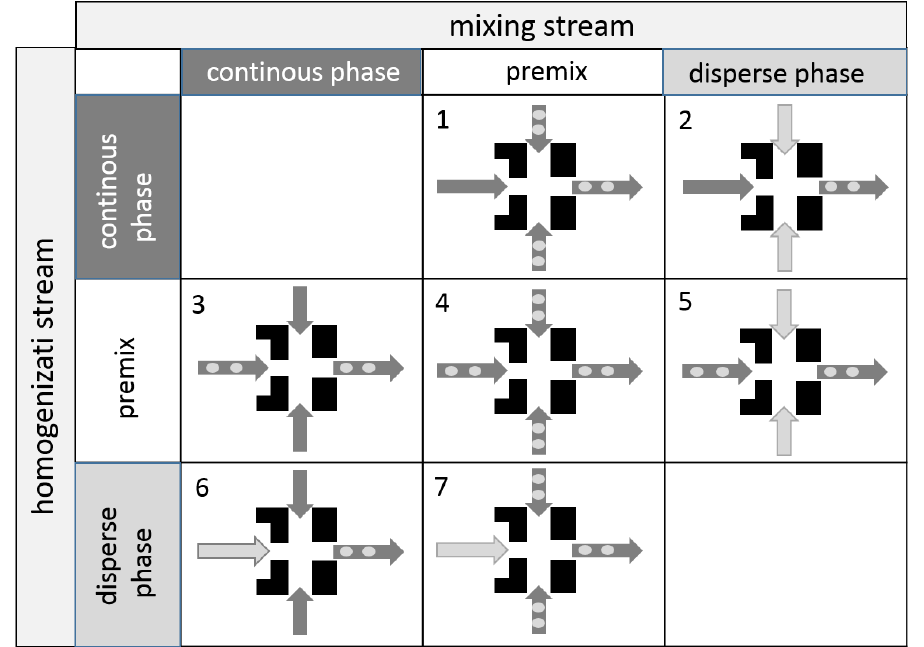
Figure 4. Operational modes of SEM adapted from [19]. The different phases (continuous phase, premix, disperse phase) are displayed in different colors according to the axes.